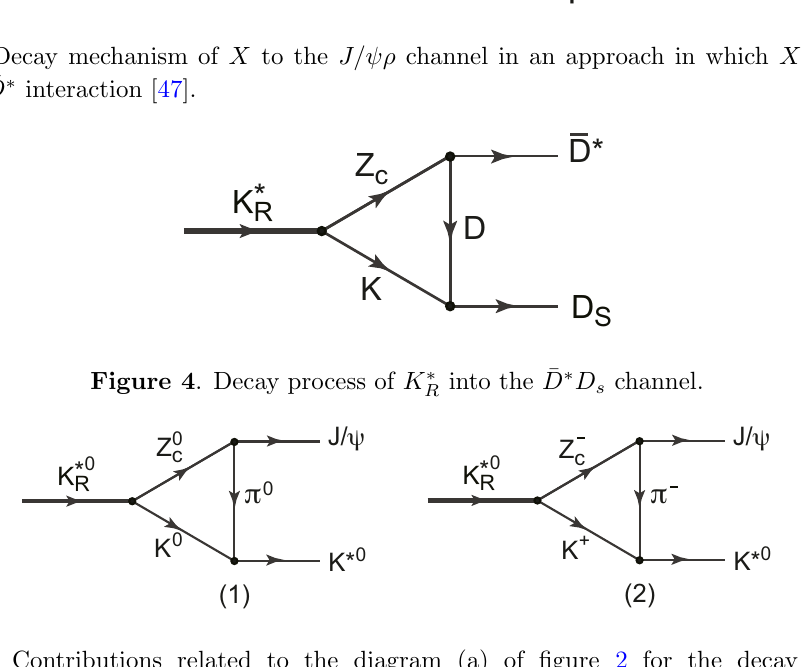
Figure 5 . Contributions related to the diagram (a) of (cid:12)gure 2 for the decay mechanism K (cid:3) 0 ! J= K (cid:3) 0 R